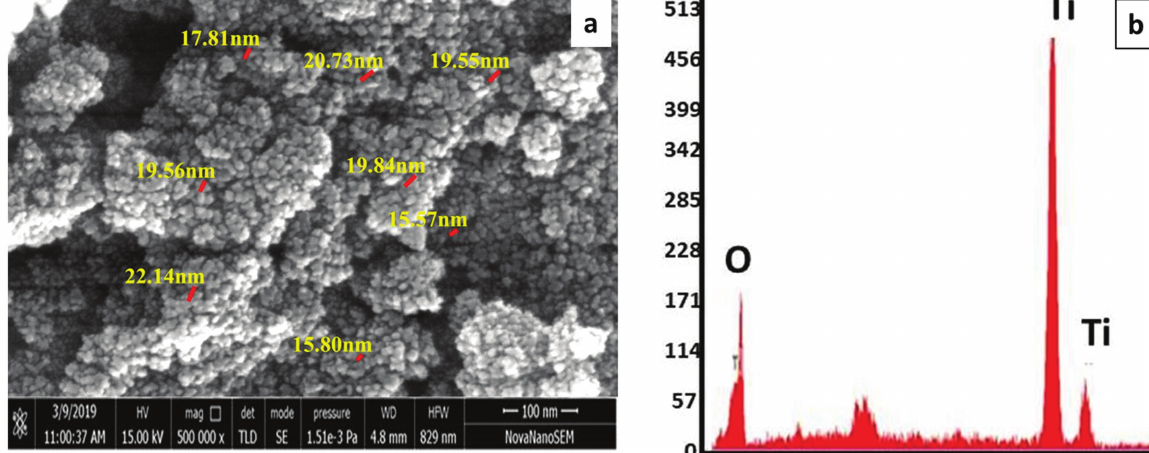
Figure 5: SEM-EDX image of synthesized TiO